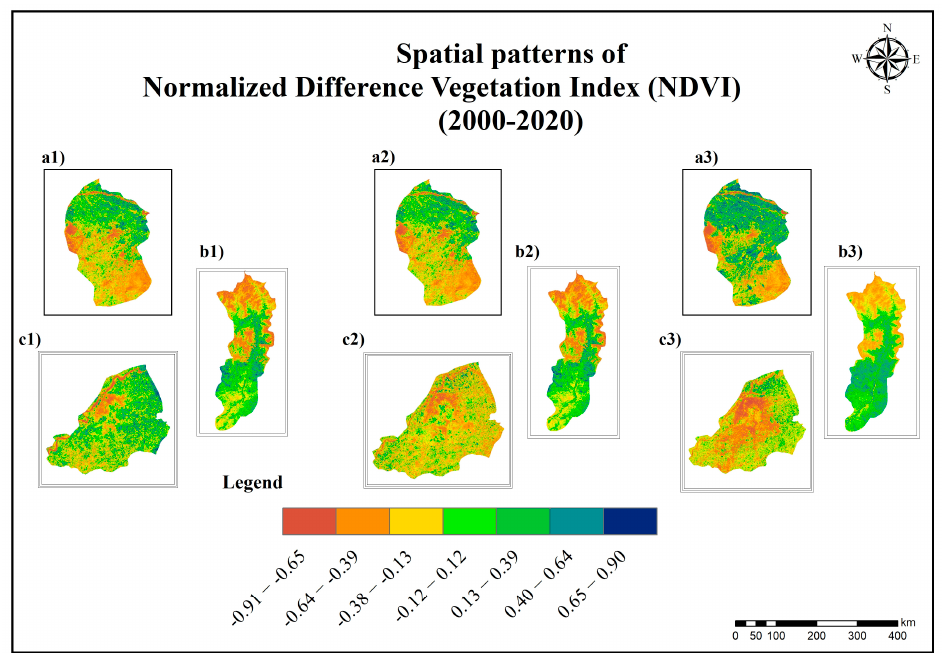
Figure 7. Spatial patterns of normalized difference vegetation index (NDVI) over sites a, b, and c from 2000–2020. Note: ( a1 ) Peshawar 2000, ( a2 ) Peshawar 2010, ( a3 ) Peshawar 2020; ( b1 ) Swat 2000, ( b2 ) Swat 2010, ( b3 ) Swat 2020; ( c1 ) Lahore 2000, ( c2 ) Lahore 2010, and ( c3 ) Lahore 2020. Correlation statistics revealed a strong relationship for sites (a) and (c) with overall values of 0.70 or above for R 2 (Table 4). For site (c) Lahore, a decreasing trend for NDVI produced R 2 values of (c1) 0.83, (c2) 0.72, and (c3) 0.59, with a significant decrease over the central and southern parts of the area. Similarly, for sites (a) Peshawar and (b) Swat, an increasing trend and strong correlation was found for the R 2 at (a1) 0.78, (a2) 0.70, (a3) 0.84, (b1) 0.58, (b2) 0.61, and (b3) 0.69. Table 4. Linear regression analysis over the sites (a, b, and c). Peshawar y = a + b × x y = a + b × x y = a + b × x Plot